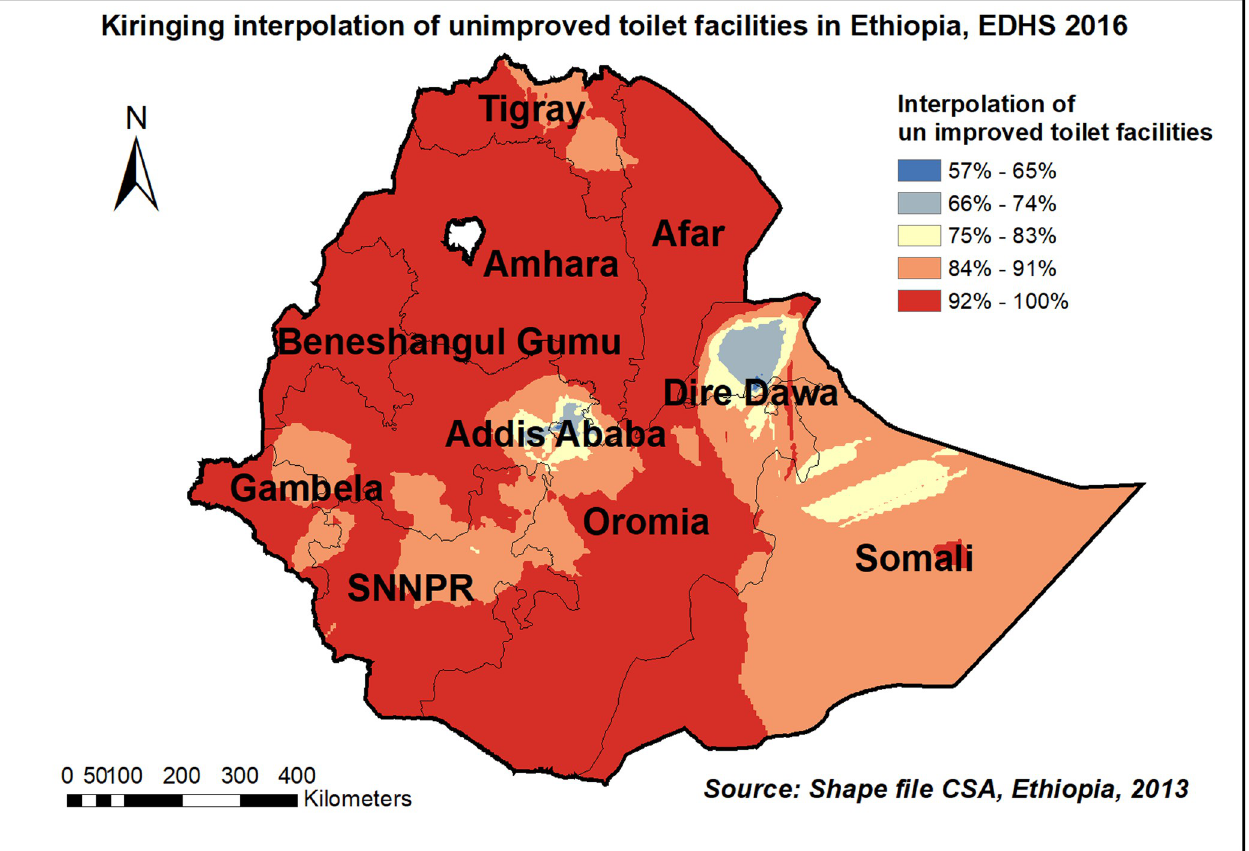
Fig 9. Kriging interpolation of unimproved toilet facilities in Ethiopia, EDHS 2016, shapefile from 2018 GADM and plotted using ArcMap version 10.7 software.